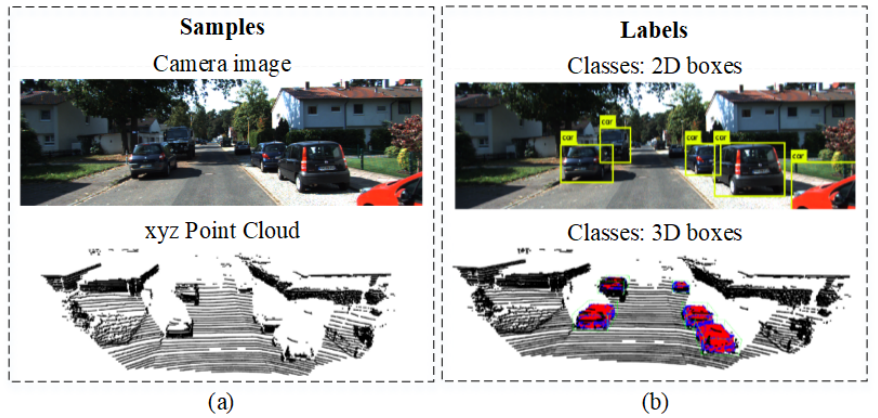
Figure 7. Pairs of samples and labels commonly used in environment perception DNNs. ( a ) Input RGB image and 3D point cloud. ( b ) Labels of objects of interest annotated in 2D on images and in 3D onto point cloud data, respectively.